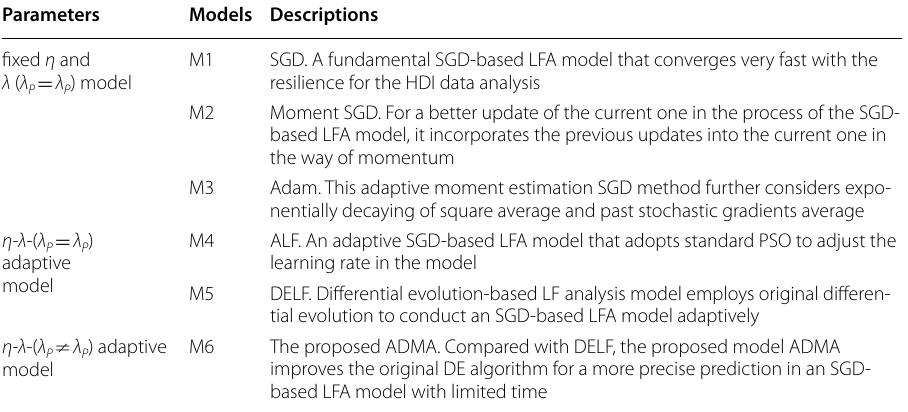
Table 3 Summary of the compared models